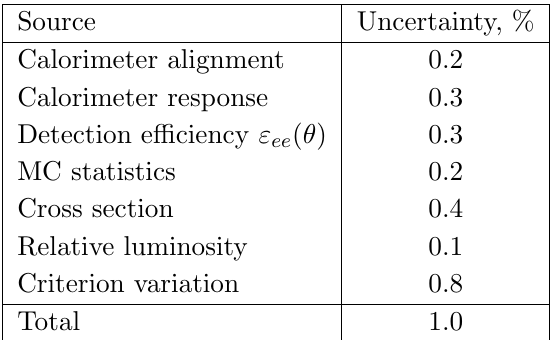
Table 1 . Results of two di(cid:11)erent data (cid:12)ts performed for (cid:0) ee ( J= ) and (cid:0) ee ( J= ) (cid:1) B hadrons ( J= ) determination.